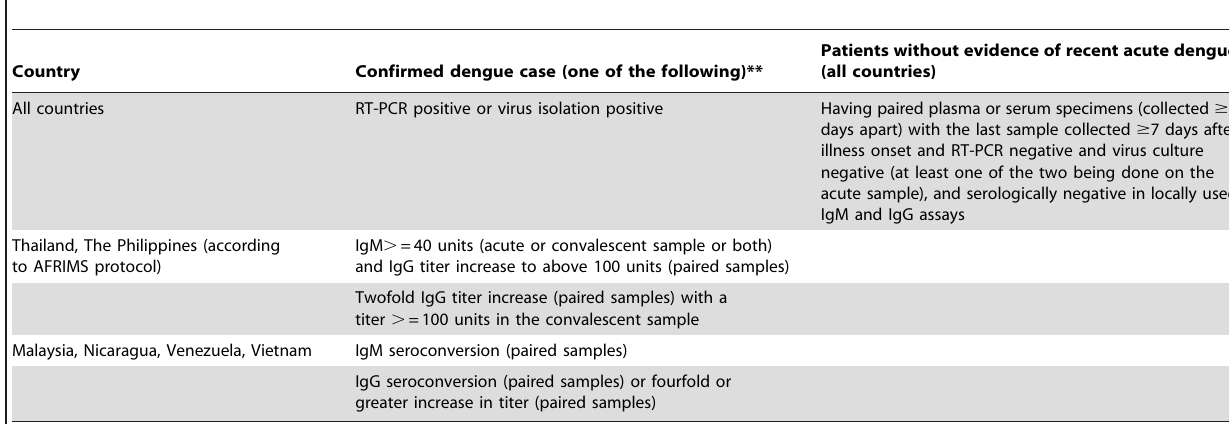
Table 2. Laboratory criteria employed at country level for dengue laboratory classification as confirmed dengue case.*